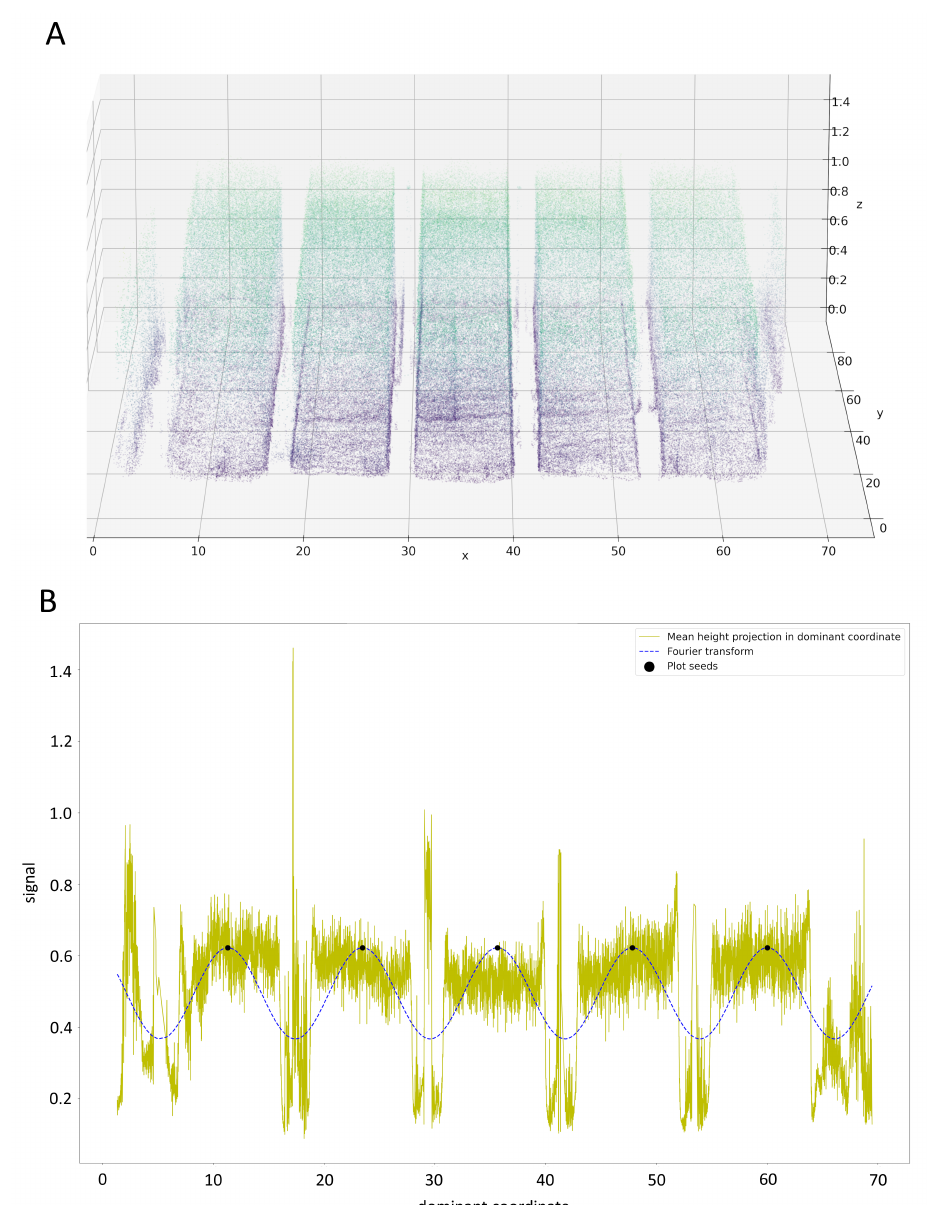
Figure 7. ( A ) Vegetation points after rotation (experimental blocks are visible in the side view); ( B ) Fourier transformation of “vegetation point signal” in the dominant